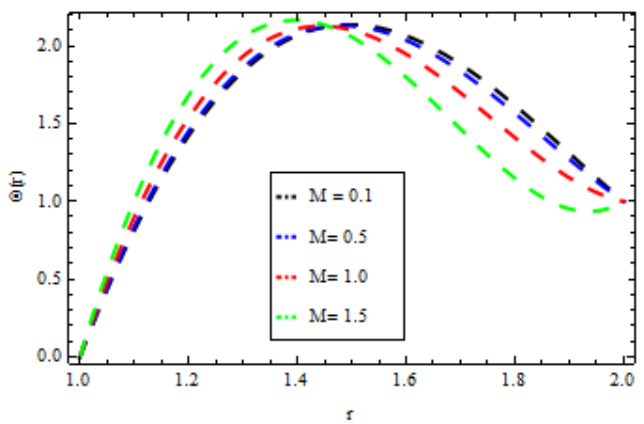
Figure 11. Temperature profile for various values of M when δ = 2, β = 0.2, K = 0.2, Br = 1.